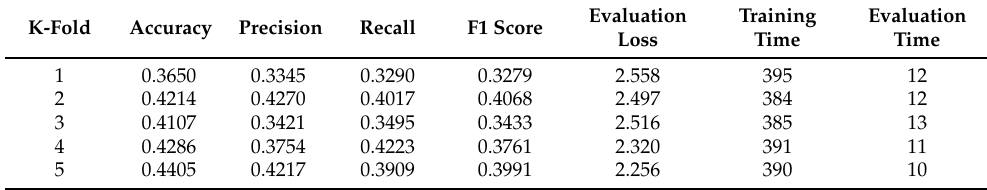
Table 8. BERT—Brexit Blog Corpus